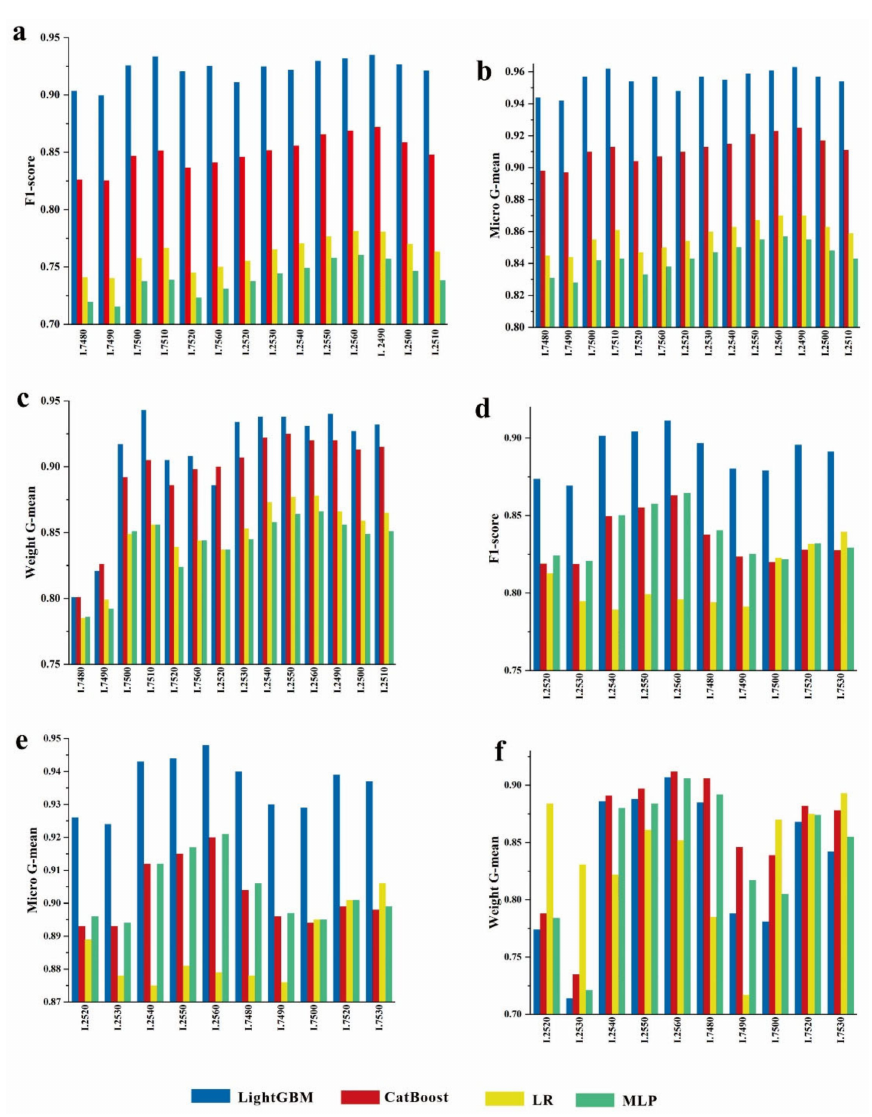
Figure 15. Comparison of model performances through the F1-score, macro-G-Mean, and micro-G- Mean in Case A ( a – c ) and Case B ( d – f ) using bar